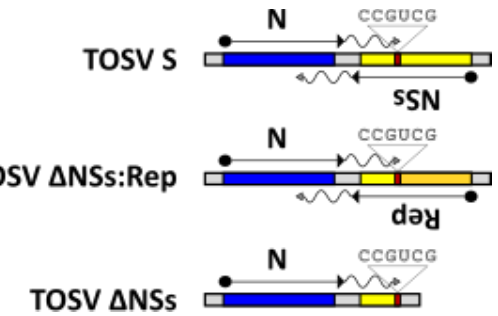
Figure 4. The rTOSV NSs deletion mutants. The rTOSV with NSs removed was generated from NSs deletion plasmids which replaced or deleted the NSs ORF (yellow) whilst retaining the N mRNA termination signal (CCGUCG). N ORF is represented in blue. The N mRNA termination signal resides within the NSs ORF. Reporter (Rep) (orange box) constructs where the NSs ORF has been replaced by a reporter gene retain a short C-terminal peptide of NSs containing the N mRNA termination signal through to the authentic NSs stop codon. For the ∆ NSs construct, the NSs stop codon and the N mRNA termination signal were maintained, but the remainder of the ORF was deleted.